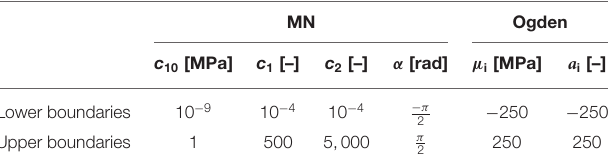
TABLE 3 | Upper and lower boundaries of the MN and third order Ogden constitutive model parameters used in the parameter fitting.